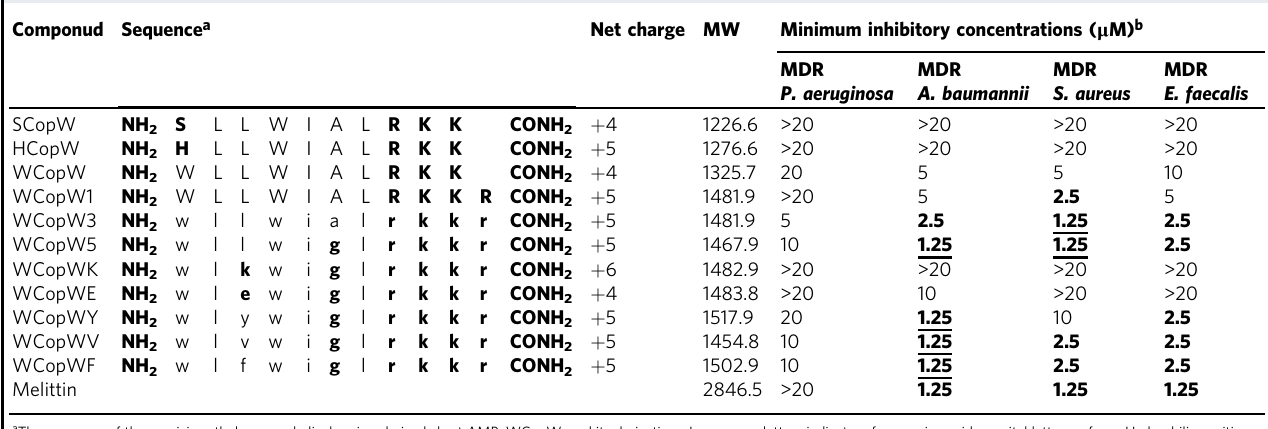
Table 1 Sequence and activity of WCopW-derived